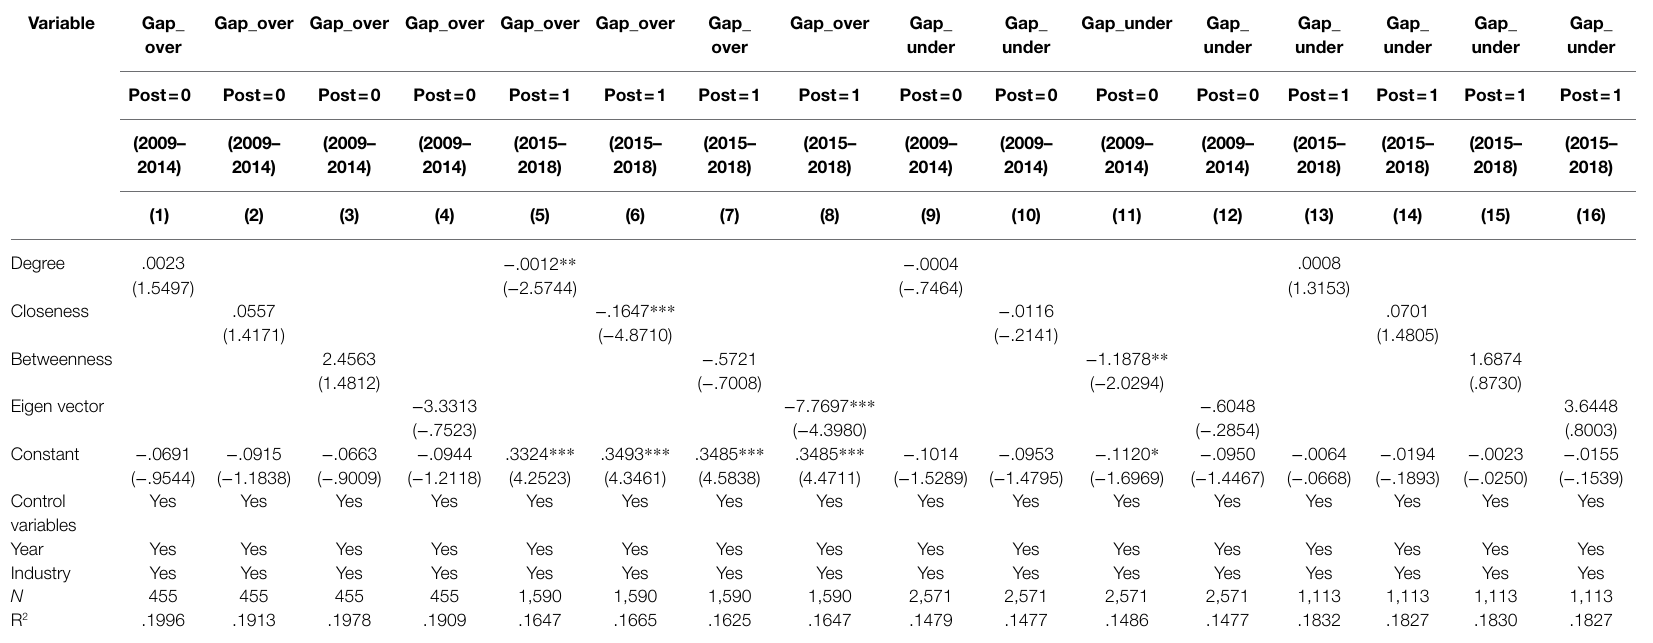
TABLE 4 | Alternative measurements of board network